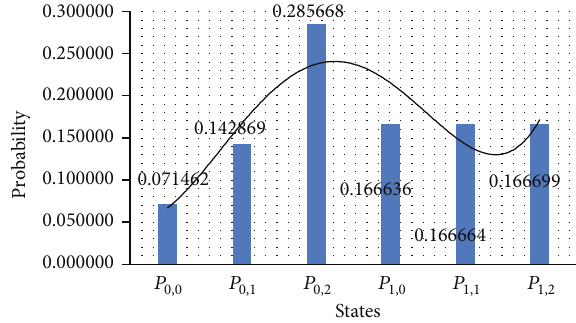
Figure 7: Random mobility example using a 2 × 3